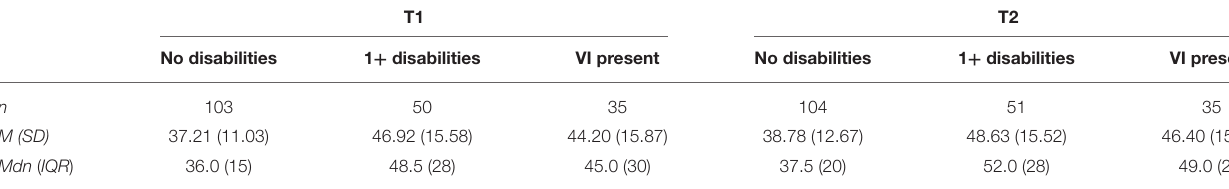
TABLE 2 | Descriptive statistics for UCLA loneliness by subgroup at T1 and T2.